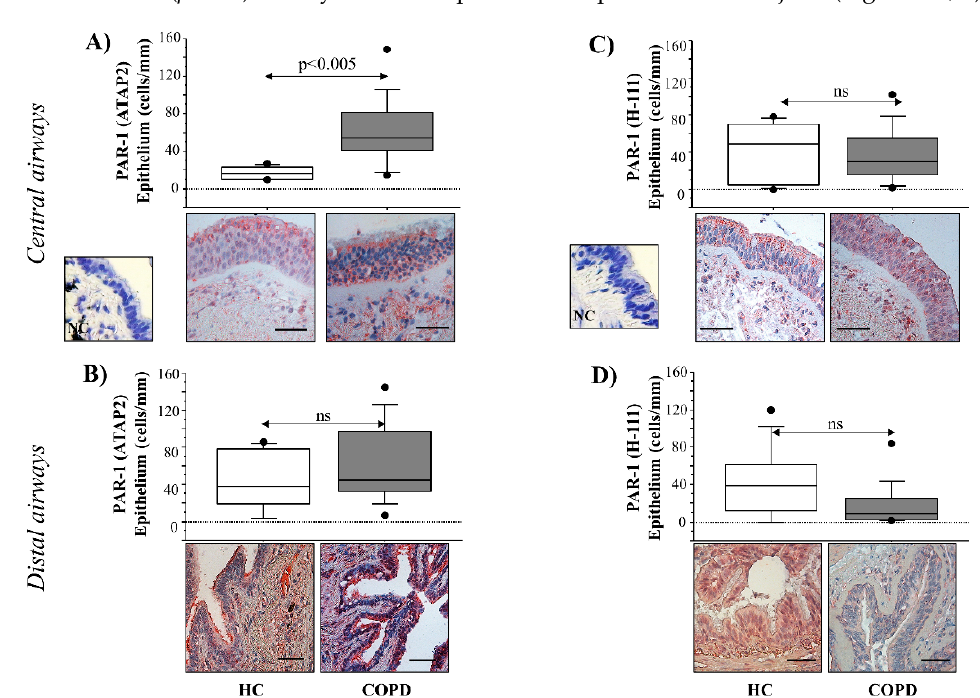
Figure 1. Immunoreactivity of anti-PAR-1 ATAP-2 Ab and anti-PAR-1 H-111 Ab in surgical specimens from central and distal airways of HC (n = 10), and COPD (n = 15) subjects. ( A , B ) Cells were stained with an anti-PAR-1 ATAP-2 Ab and ( C , D ) with an anti-PAR-1 H-111 Ab. Negative control was performed using rabbit immunoglobulins (see Section 2 for details). The scale bar is 50 µ m. Counts of the number of positive epithelial cells/mm in the basement membrane is shown. Representative Immunostaining at 40 × magnification is shown. Results were expressed as box plots representing median and 25–75 percentiles. Statistical analysis was performed with the Kruskal–Wallis test, followed by Fisher’s PLSD correction for multiple comparisons. Significance was accepted at p < 0.05.